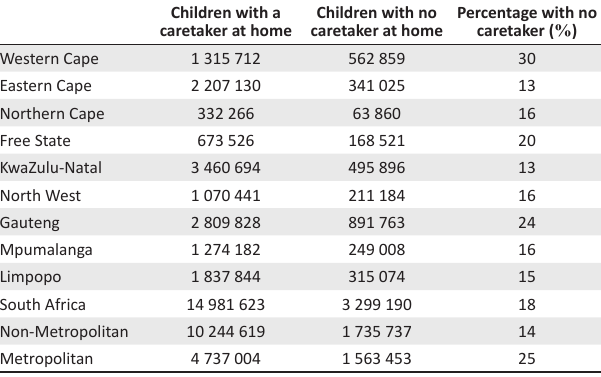
TABLE 2: Number of children aged 0 to 18 at home with or without an adult caretaker in the household if all employed people were to be back at work. Children with a Children with no Percentage with no caretaker at home caretaker at home caretaker ( % ) Western